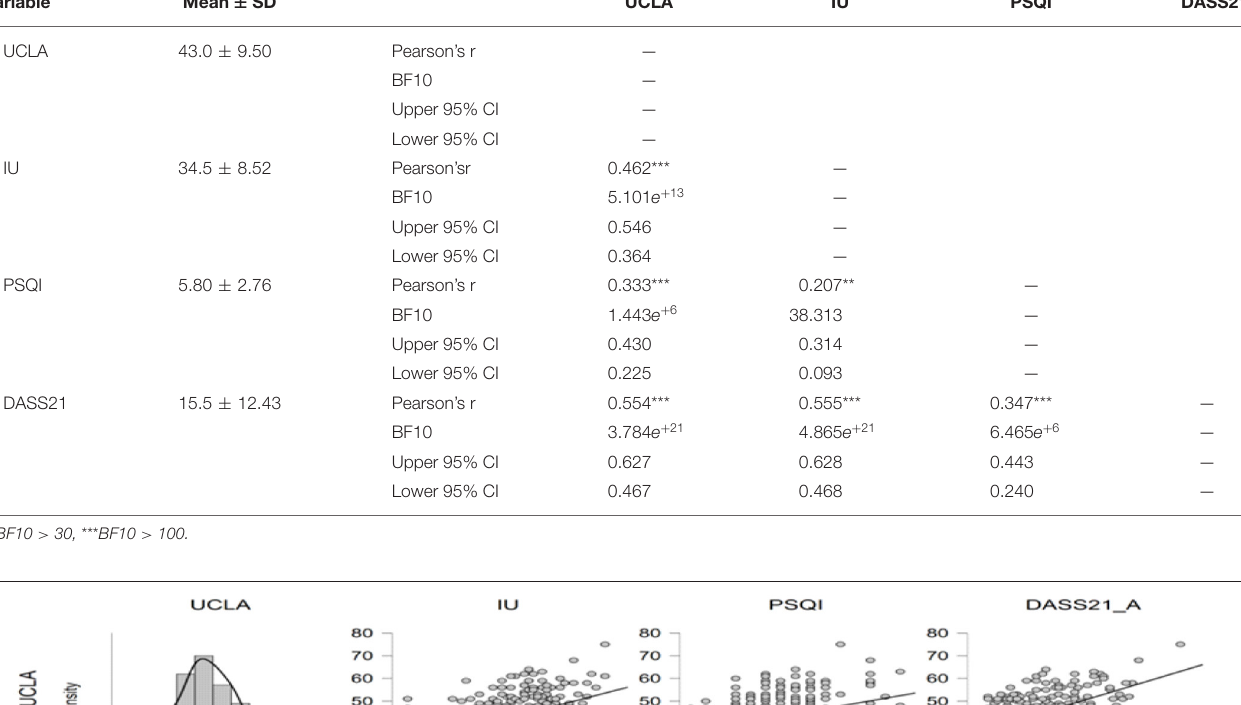
TABLE 2 | Mean, standard deviation, and Pearson Bayesian correlation matrix. Variable